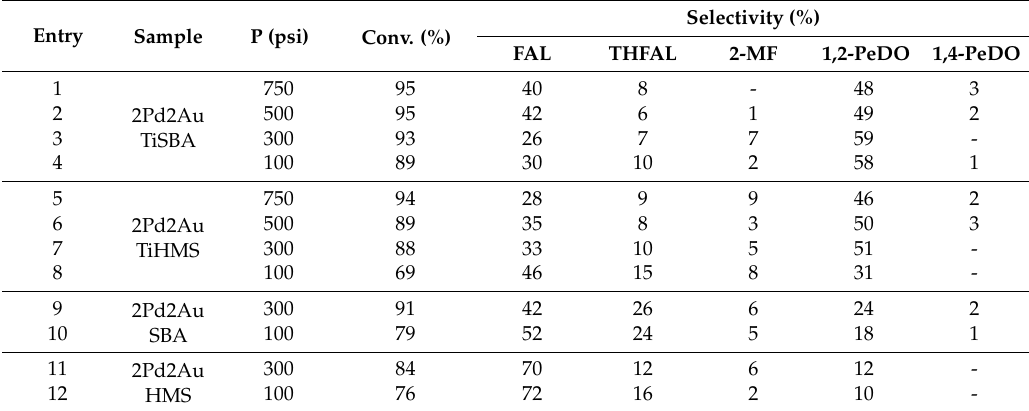
Table 2. Effect of H 2 pressure on FFR hydrogenation over Ti-doped